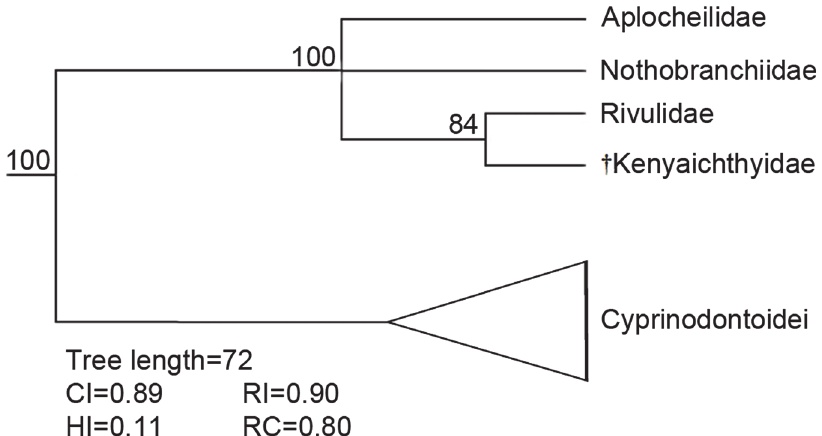
Fig 14. 50% majority-rule consensus tree for the Cyprinodontiformes and † Kenyaichthys gen. et sp. nov. (red arrow) based on 72 morphological characters as used in the studies of Costa [1, 48, 49, 50, 55] created using PAUP [51]. Numbers above nodes refer to bootstrap values (based on 1000 replicates). Abbreviations: CI, consistency index; HI, homoplasy index; RI, retention index; RC, rescaled consistency